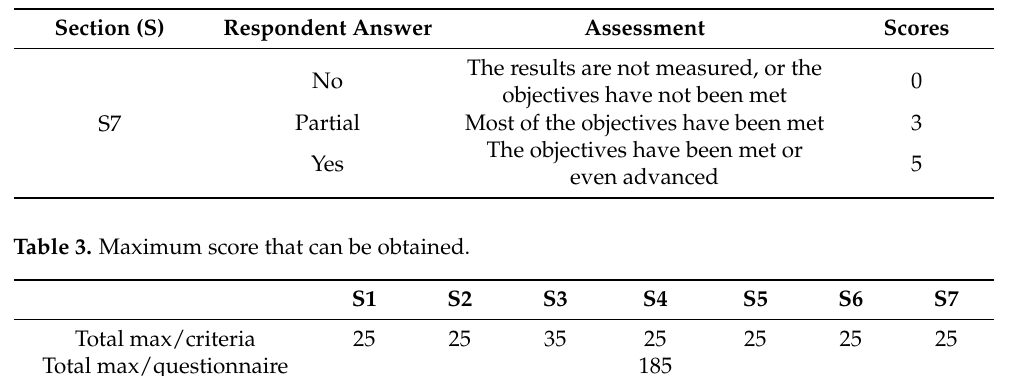
Table 2. Evaluation rules on Section 7 of questionnaire.